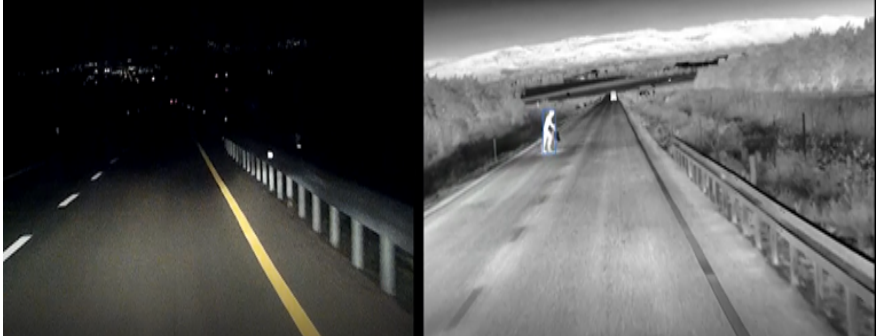
Figure 2. Use of the ADASKY LWIR camera to improve visibility on roads.